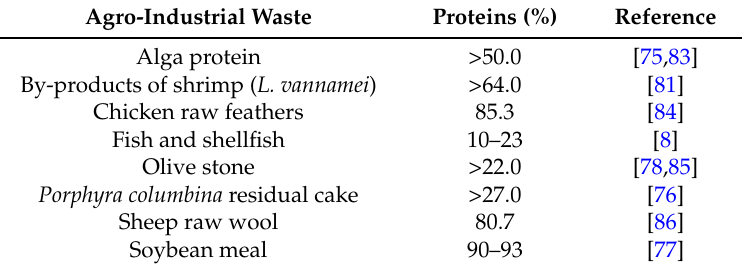
Table 1. Protein content of agro-industrial waste available to obtain bioactive